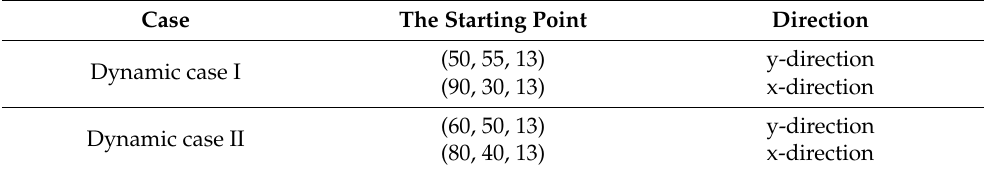
Table 3. The threat information of the dynamic environment.